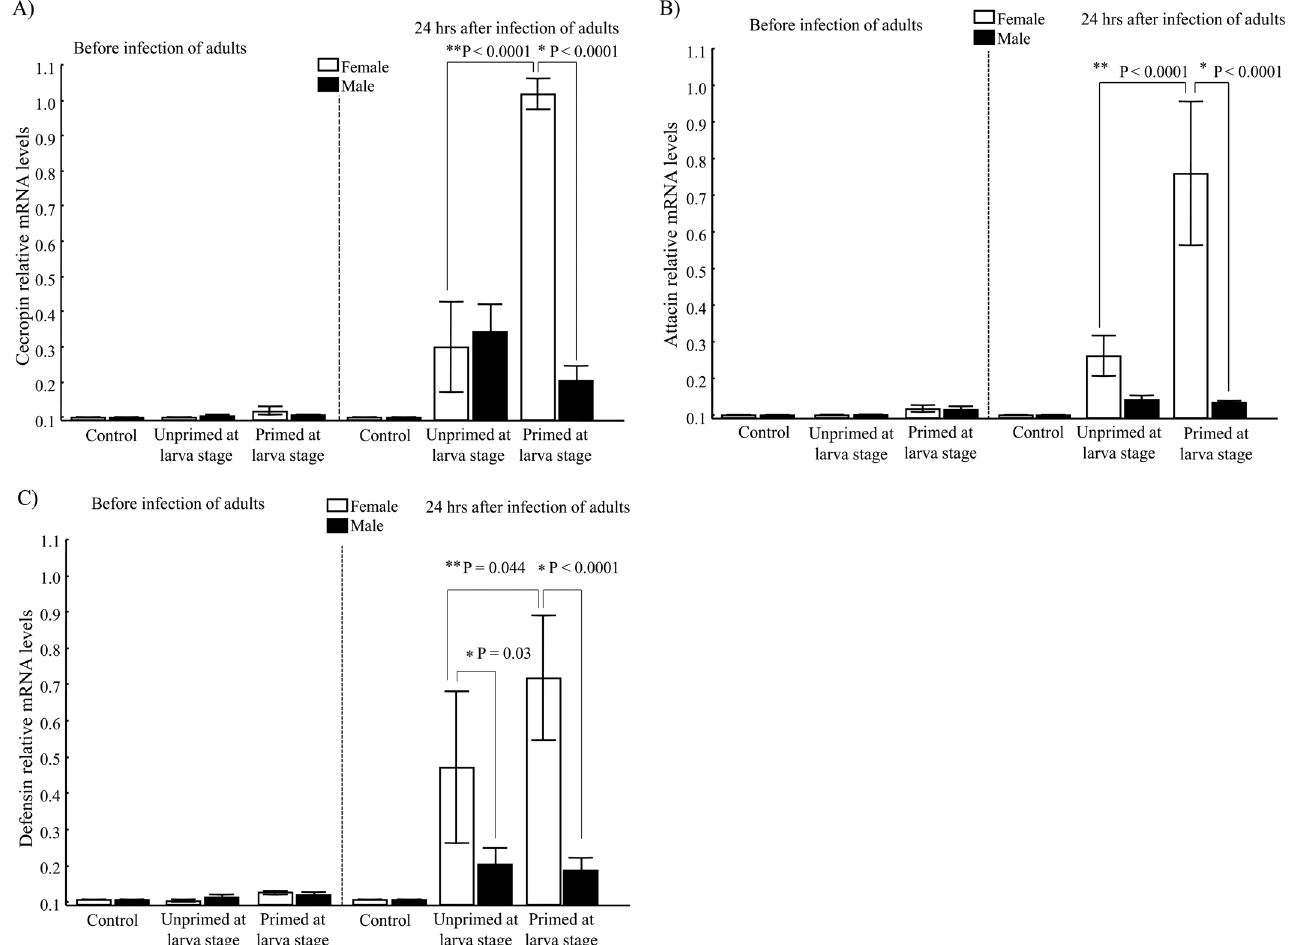
Fig 5. Peptide transcription in adults of both sexes, with or without priming induced at the larval stage. (A) Analysis of transcriptional levels through quantitative RT-PCR before and after infection of adults, measuring cecropin, (B) Analysis of transcriptional levels through quantitative RT-PCR before and after infection of adults, measuring attacin, (C) Analysis of transcriptional levels through quantitative RT-PCR before and after infection of adults, measuring defensin. ( * ) indicates a significant difference between males and females, and ( ** ) indicates a significant difference between the UnPr and Pr